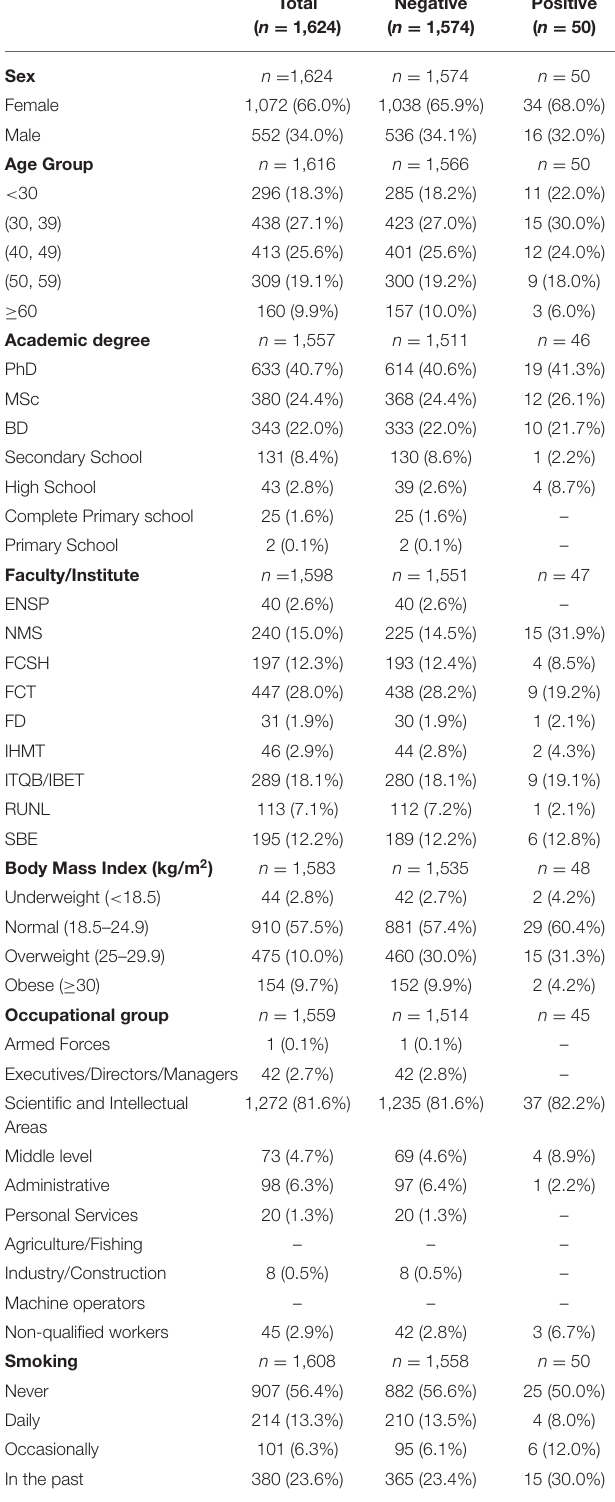
TABLE 2 | Sociodemographic and health-related characterisation of NOVA University subjects, stratified based on SARS-CoV-2 serology